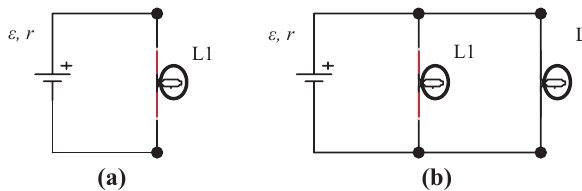
Fig. 5. The variation of the lamp brightness in an electric circuit with a real